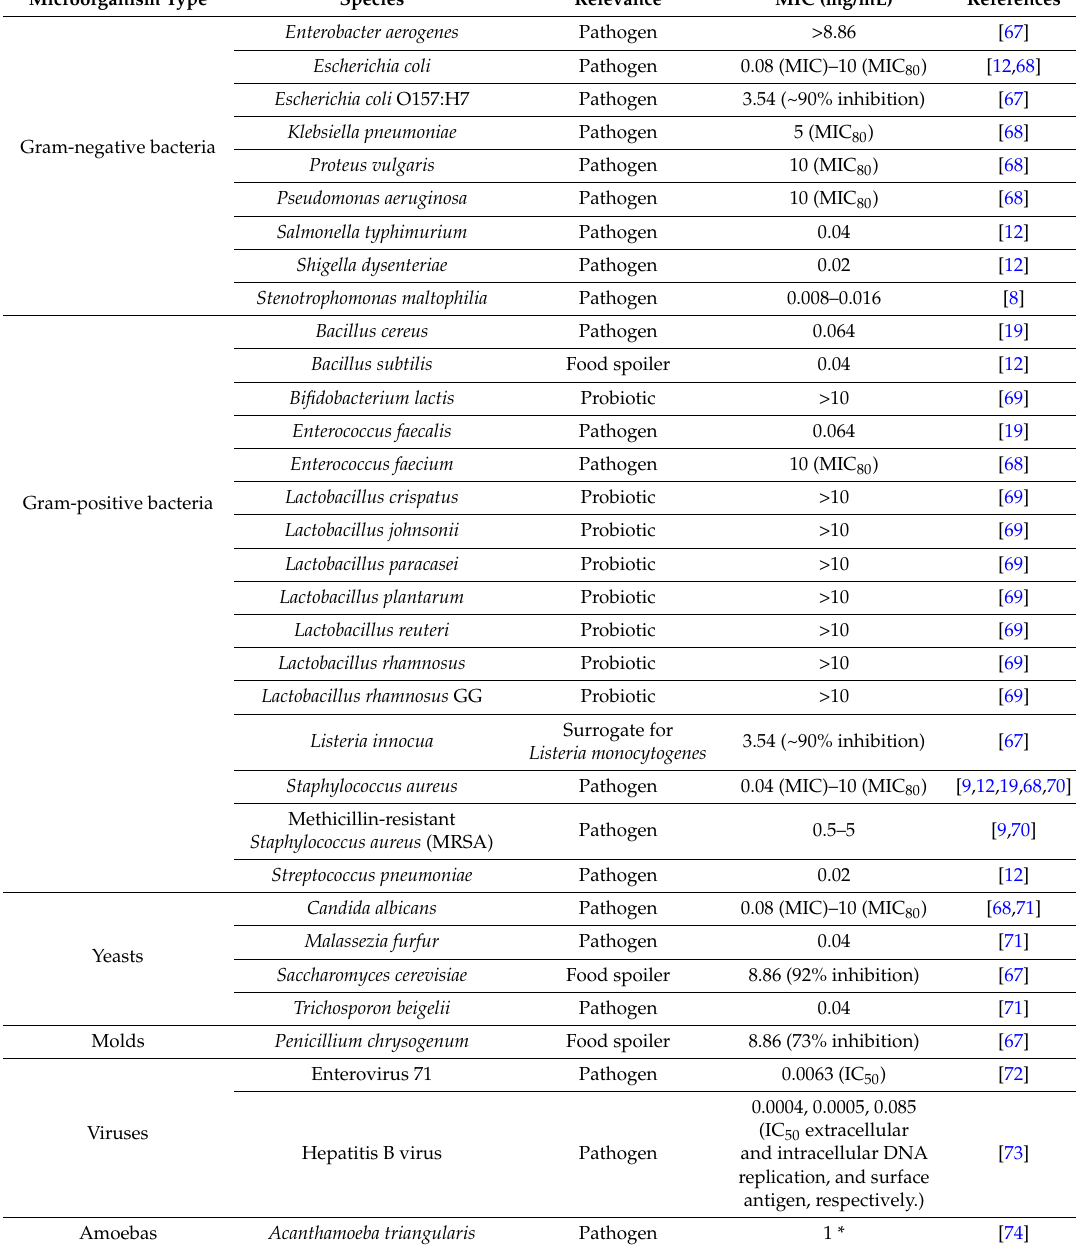
Table 3. Antimicrobial activity of chlorogenic acid against different